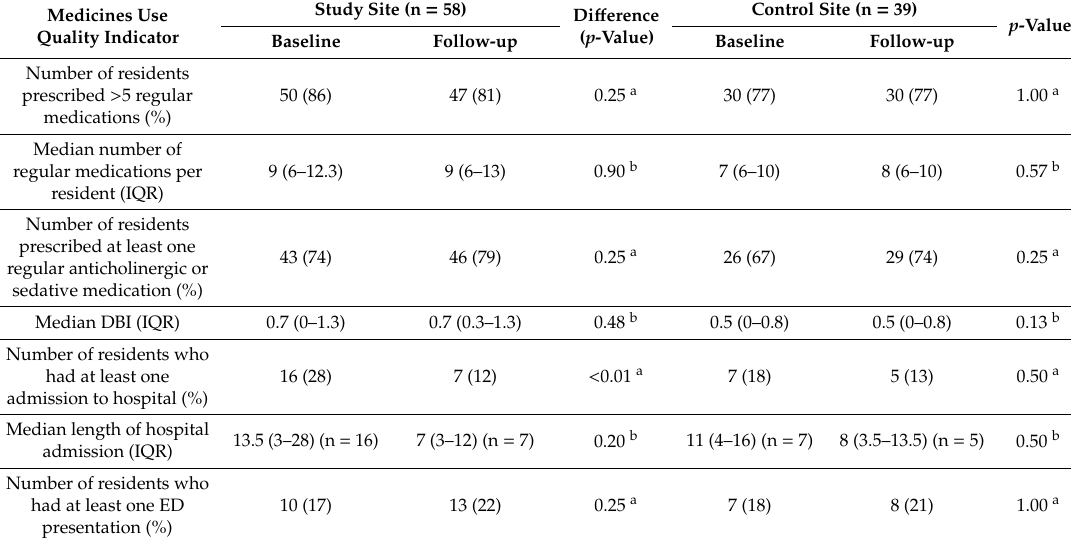
Table 2. Summary of use of medicines quality indicators.